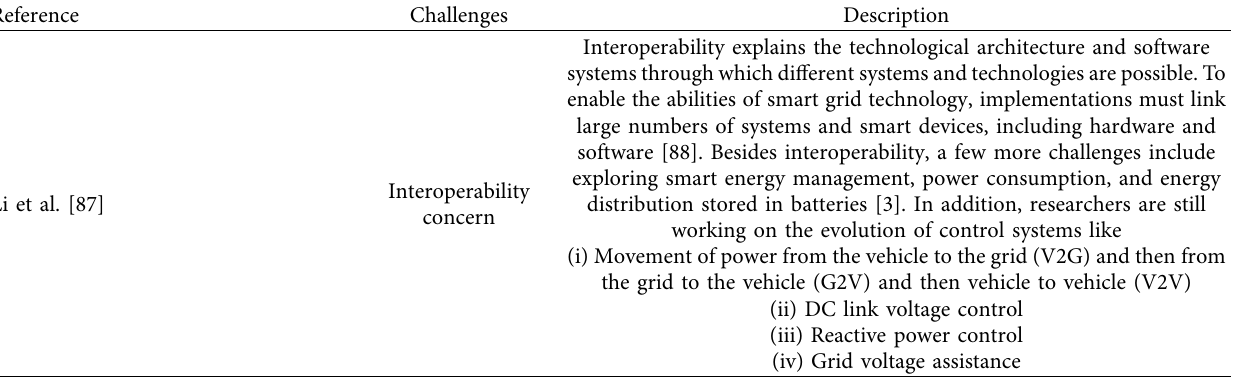
Table 3: Technical challenges of smart